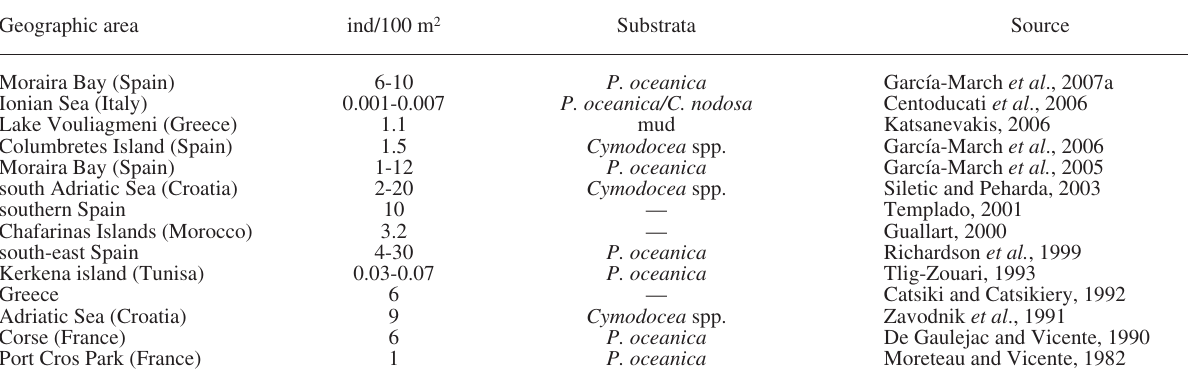
Table 5. − densities of P. nobilis reported from literature considering geographical area and substrata. Geographic